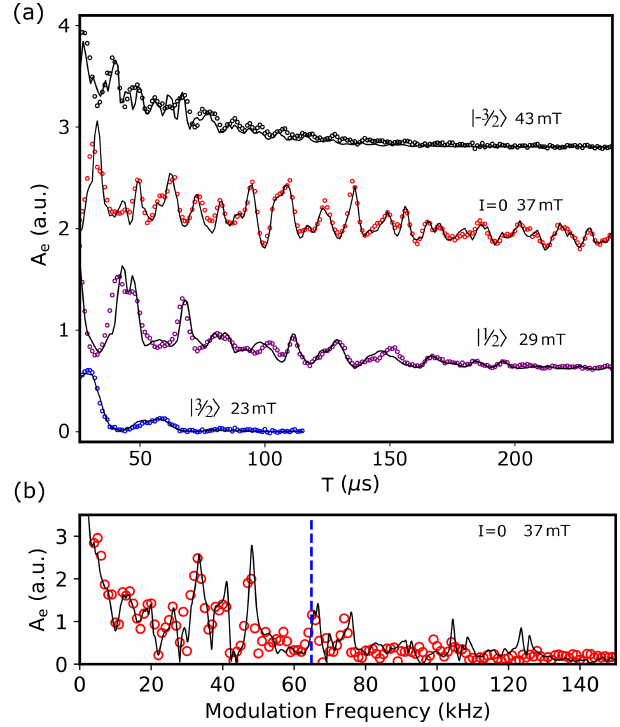
Figure 7. Two-pulse ESEEM on Er : CaWO 4 . (a) Integrated echo area A e as a function of the inter-pulse delay τ for four values of B 0 corresponding to different transitions. Open circles are measure- ments, and solid lines are the results of the ESEEM calculations as explained in Sect. S5.1. (b) Measured (open red circles) and computed (solid line) fast Fourier transform of the I = 0 data. The dashed blue line shows the Larmor frequency of 183 W nuclei in free